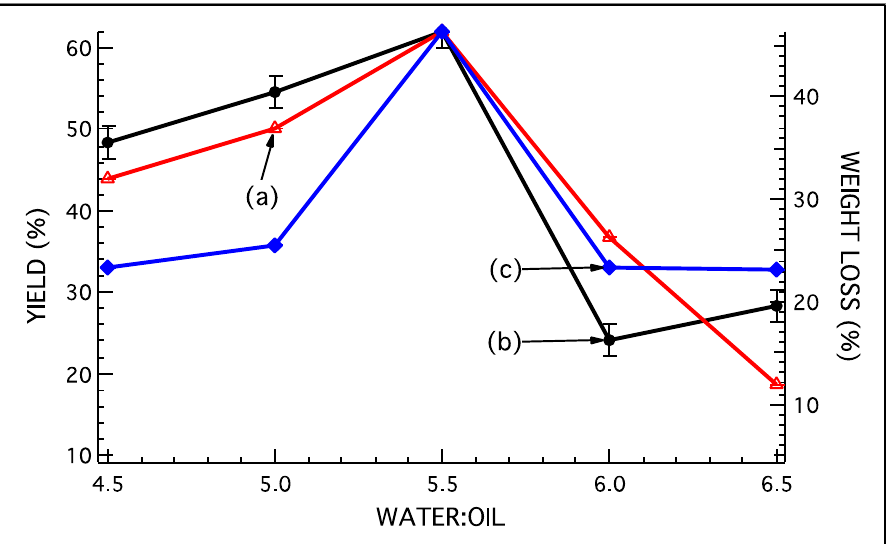
Figure 5. Percentage of weight loss due to HDI (a), yield (b), and area under the NCO peak from FTIR (c) as a function of the water-to-oil ratio.